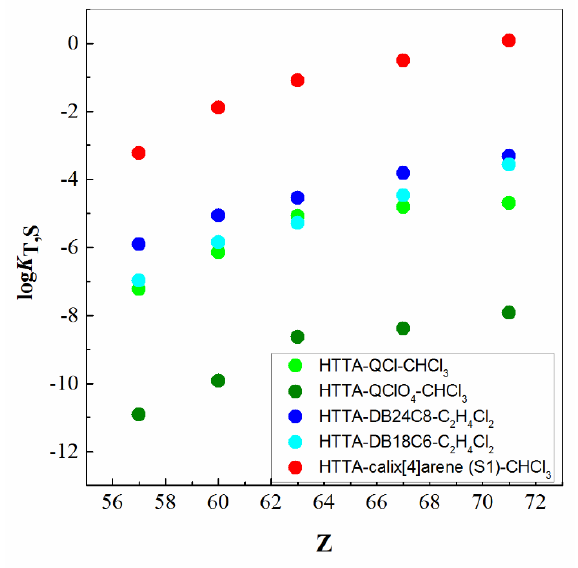
Figure 10. Comparison of synergistic solvent extraction systems for lanthanoids: log K T,S vs. Z.